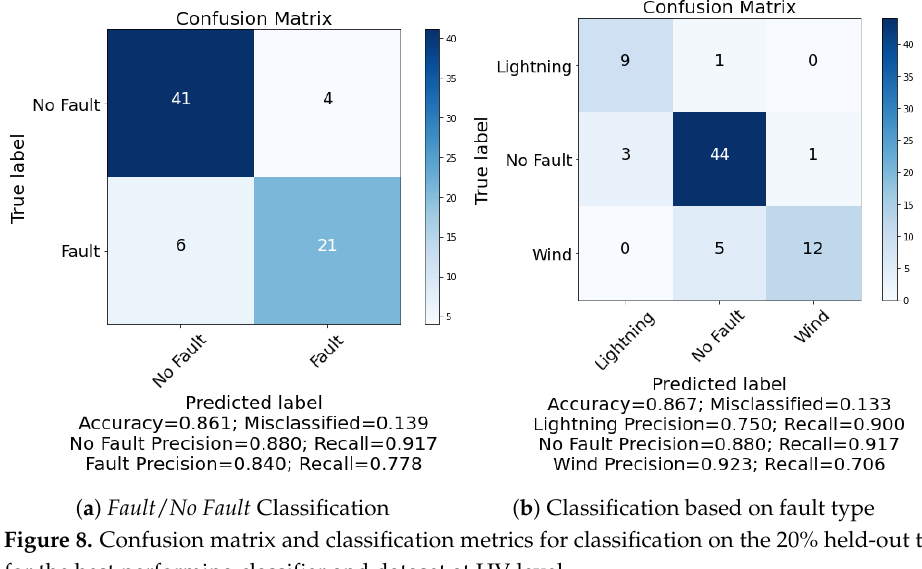
Figure 8. Confusion matrix and classification metrics for classification on the 20% held-out test set for the best performing classifier and dataset at HV